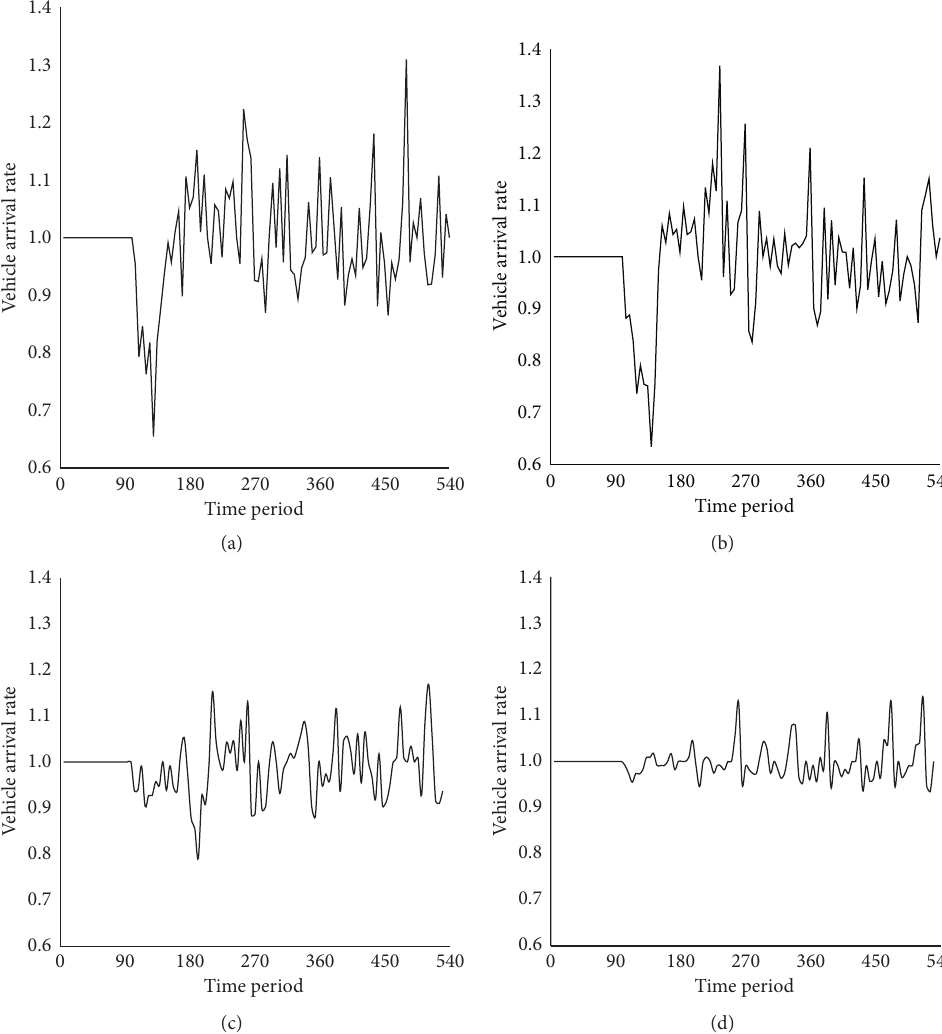
Figure 6: Vehicle arrival rate diagram under complete or partial failure. (a) Situation 3 and (b) situation 4 of complete failure show significant fluctuations. (c) Situation 5 and (d) situation 6 of partial failure situation show flat fluctuations. (a) Situation 3. (b) Situation 4. (c) Situation 5. (d) Situation